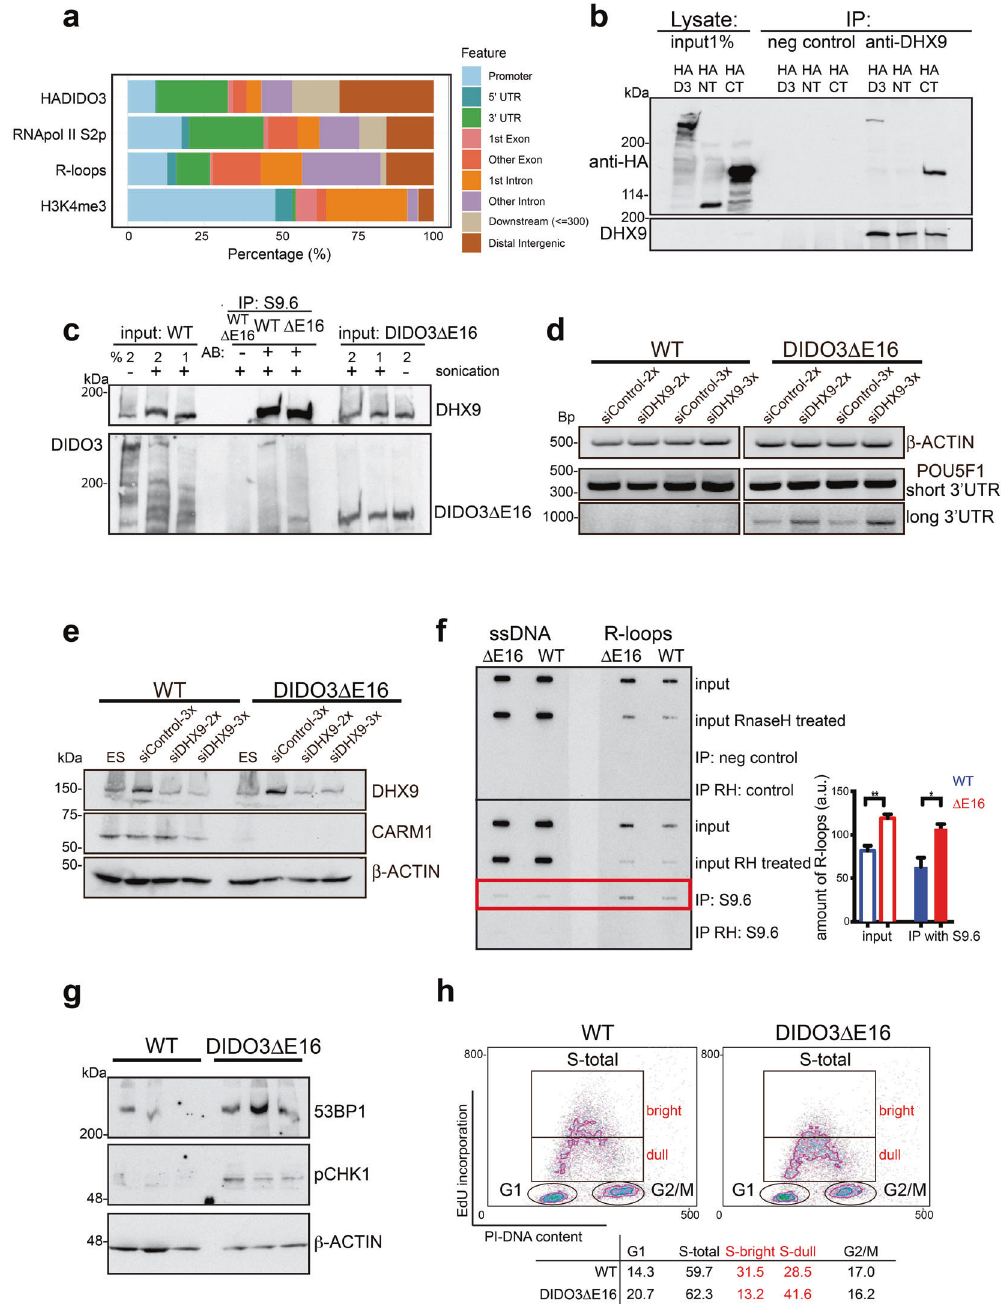
Fig. 4 Coexistence of DIDO3, RNA pol II, DHX9, and R-loops, and alterations in DIDO3 Δ E16 mutant ESC. a BED peak fi les were imported to RStudio and annotated using the R/Bioconductor package ChIPseeker. Peak annotations are depicted as a percentage for HADIDO3, RNA pol II S2p, R-loops, and H3K4me3 (histone 3 trimethylated on lysine 4). b Co-immunoprecipitation of HA-tagged DIDO3, -common N-terminal region, or -DIDO3-exon16-speci fi c C-terminal part (for constructs see [28]), and DHX9 helicase. c Co-immunoprecipitation of DIDO3 or DIDO3 Δ E16 proteins and DHX9 helicase at R-loops precipitated with the S9.6 mAb, from sonicated chromatin of WT or DIDO3 Δ E16 ESC. d Abundance of POU5f1 short and long 3 ′ UTR after two or three applications of siDHX9 or siControl in WT and DIDO3 Δ E16 ESC; β -ACTIN was used as control for equal RNA amounts. e Western blot analysis of DHX9 and CARM1 expression in WT and DIDO3 Δ E16 ESC after two or three applications of siDHX9 or siControl; β -ACTIN was used as loading control. f Left: representative example of slot-blot analysis of restriction enzyme-digested genomic DNA, before and after immunoprecipitation with S9.6 mAb, alone or treated with RNaseH1 from WTor DIDO3 Δ E16 ESC. Probes were used in duplicate; the fi rst was developed with anti-ssDNA mAb and the second with anti-R-loop mAb S9.6. Right: quanti fi cation of slot – blot bands normalized to ssDNA values with ImageJ. Bars represent mean ± SEM. Statistical analysis was done with two- tailed Student ’ s t -test, ** P ≤ 0.01; * P ≤ 0.05; DIDO3 Δ E16, n = 3; WT, n = 3. g Western blot analysis of total lysates from WT and DIDO3 Δ E16 ESC developed with anti-53BP1 and anti-phosphorylated CHK1 (pCHK1) antibodies; β -ACTIN was used as loading control. h Contour density plot of WT and DIDO3 Δ E16 ESC after a 30-min EdU pulse, showing EdU incorporation versus DNA content. The percentages of events in cytometric gates de fi ning different phases of the cell cycle are